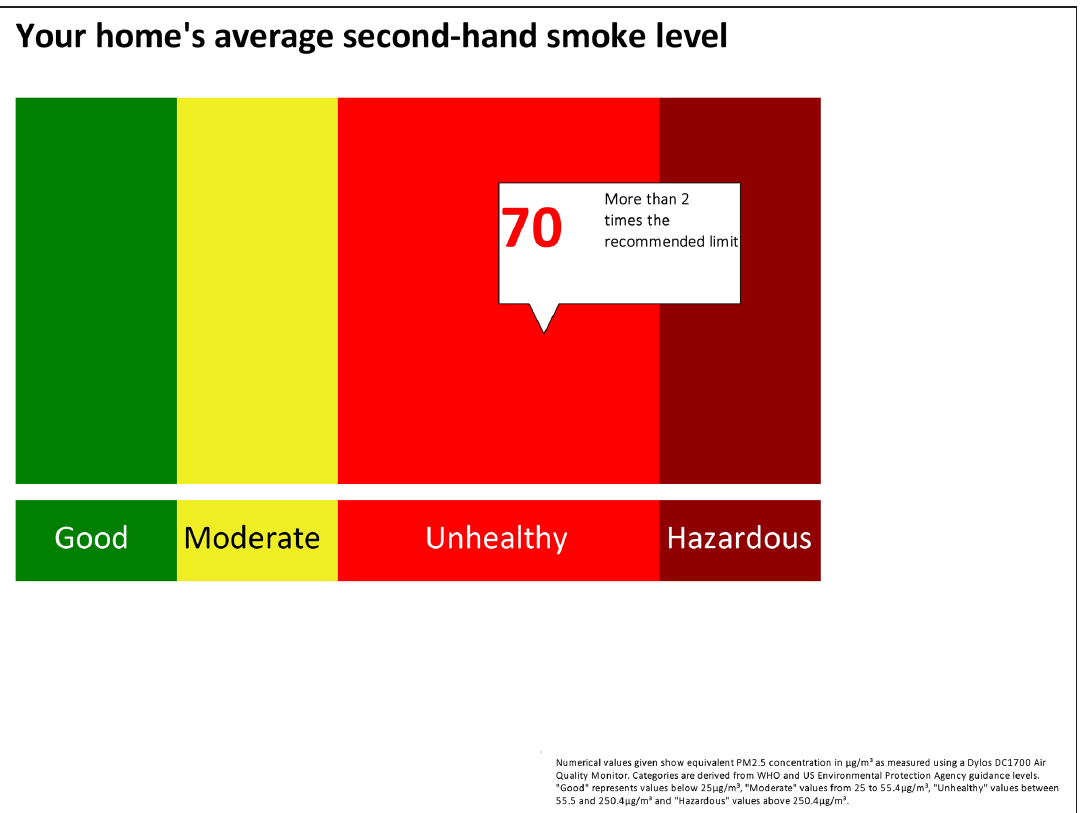
Figure 8: Examples of revised personalised feedback from a home where smoking takes place. Numerical values given show equivalent PM concentrations in µ g/m 3 as measured using a Dylos DC1700 Air Quality Monitor. Categories 2.5 are derived from WHO and US Environmental Protection Agency guidance levels. ‘Good’ represents values below 25 µ g/m 3 , ‘Moderate’ represents values from 25 to 55.4 µ g/m 3 , ‘Unhealthy’ represents levels between 55.5–250.4 µ g/m 3 and ‘Hazardous’ represents values above 250.4 µ g/m 3